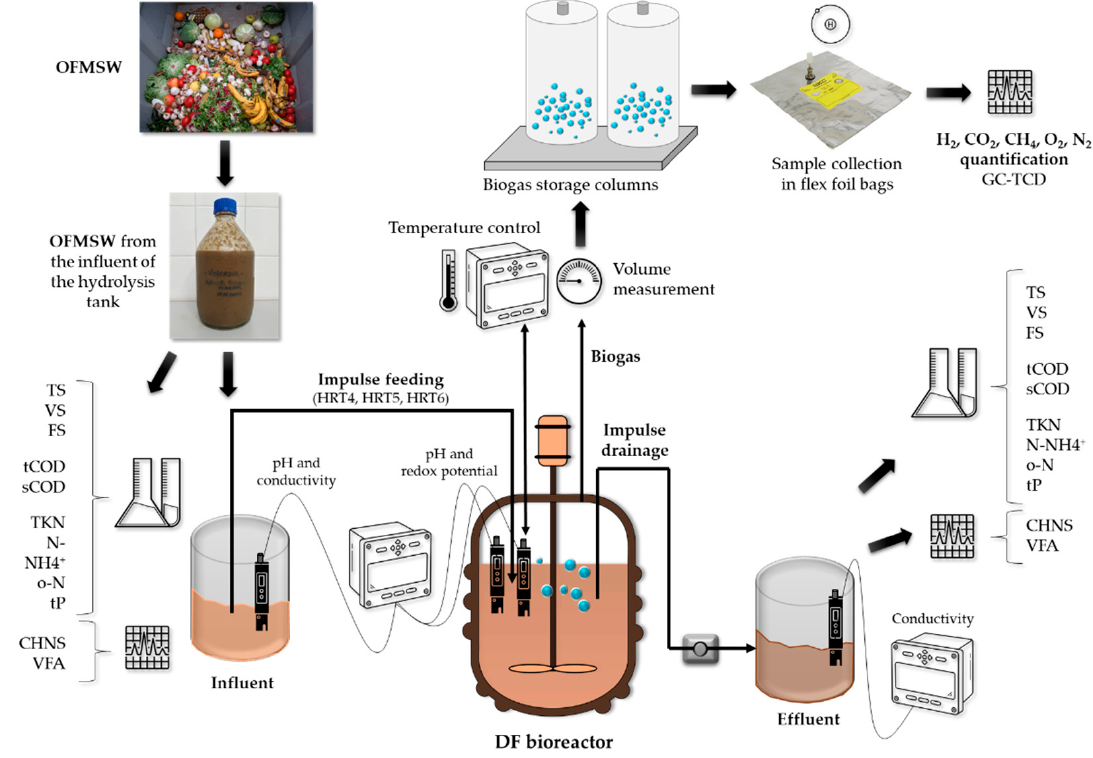
Figure 2. Synthesis of the experimental